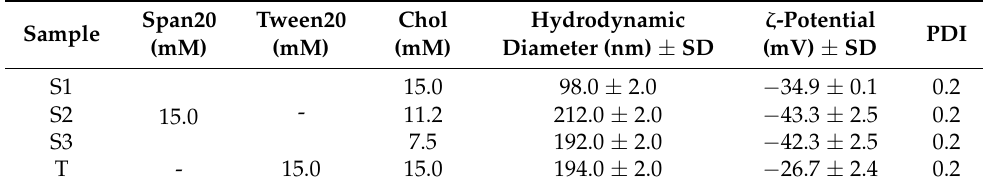
Table 1. DLS analyses of uncoated Span and Tween niosomes. Values represent the mean ± standard deviation of n = 3 sample measurements.